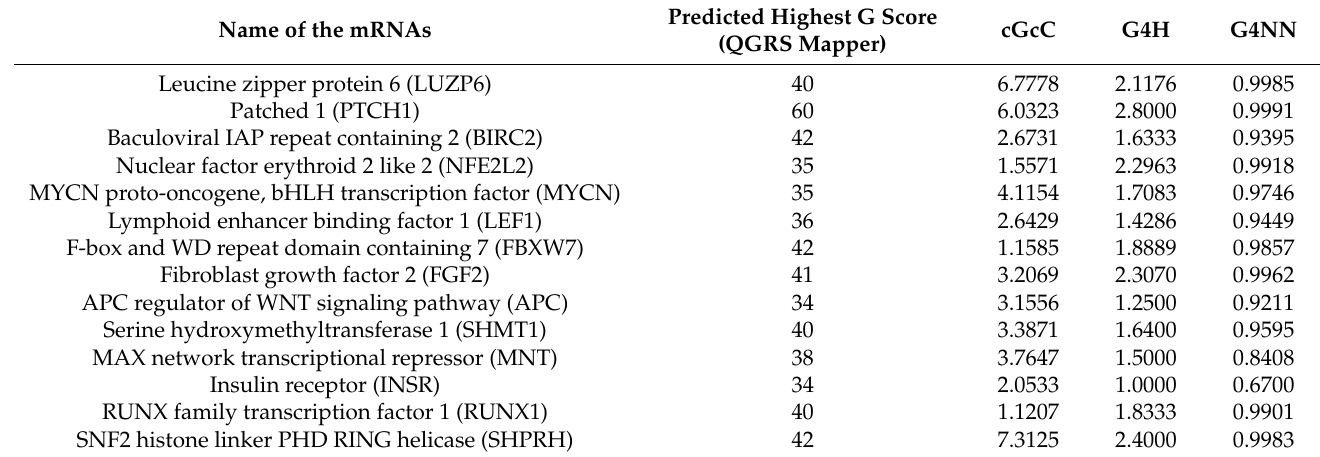
Table 1. List of mRNAs comprising high G scores ( ≥ 30) at the 5 (cid:48) UTR according to QGRS